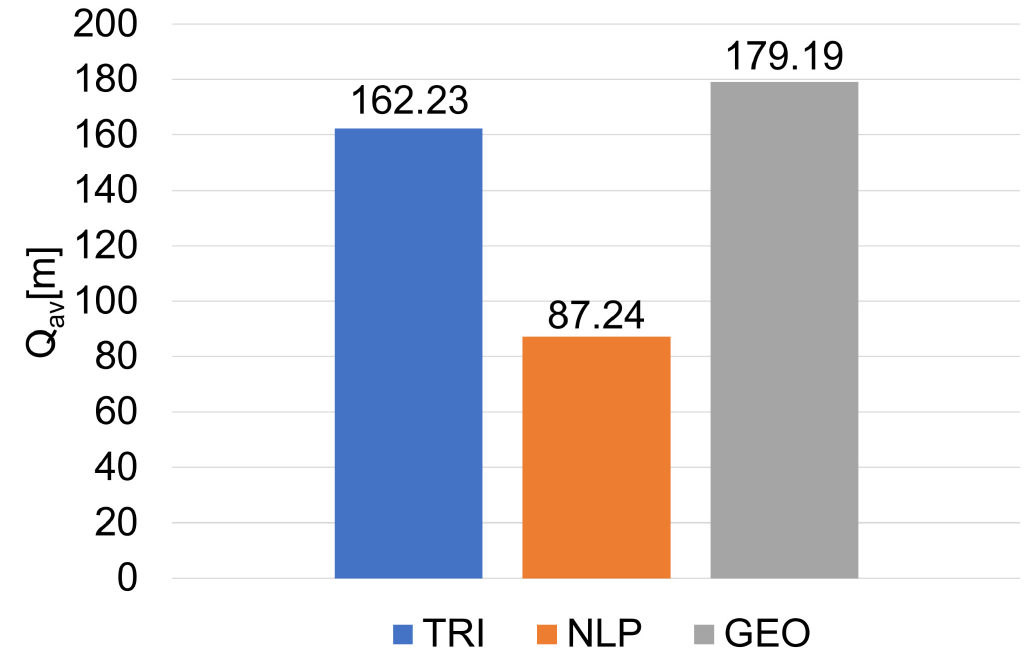
Figure 23. Results of the average quality indicators Q for localization algorithms (final filtering).